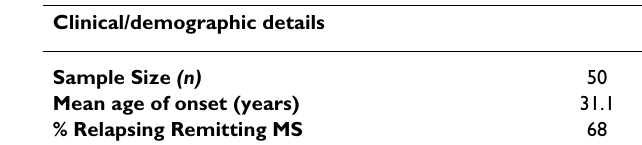
Table 1: Clinical details of MS